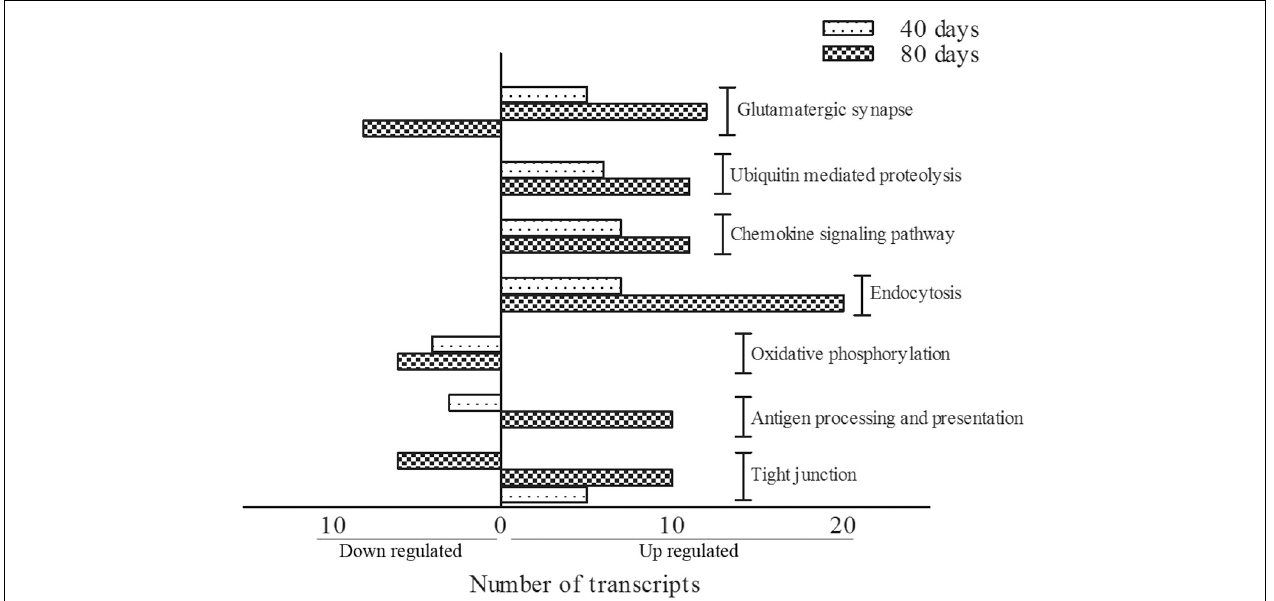
wild-types. Bars on the left indicate the number of down regulated genes, and bars on the right indicate the number of up regulated genes, for each